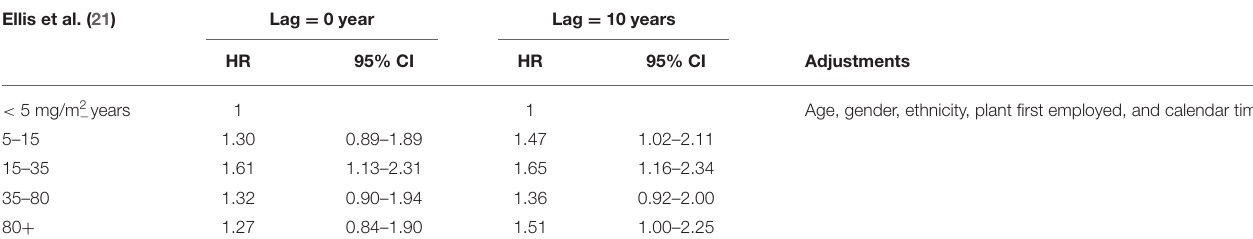
TABLE 11 | Internal analyses